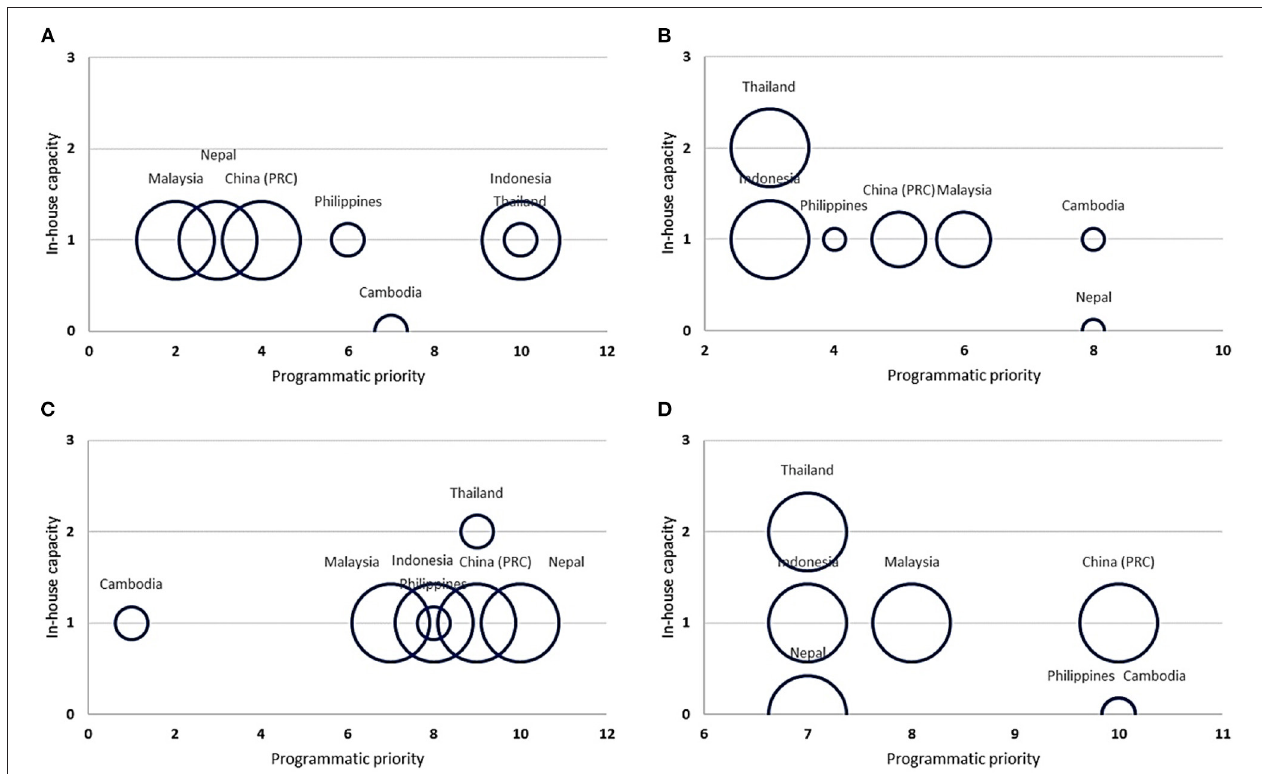
FIGURE 5 | Comparative mapping of domestic scientific capacity, programmatic priority and funding status for 4 crop protection domains in seven Asia–Pacific countries. Plots are drawn for pest/disease biology and ecology (A) , biological control (B) , agronomy and agro-ecology (C) and varietal resistance (D) . For each domain and country, bubble size refers to the current funding status (i.e., low, intermediate, high). In all graphs, except for B, the largest bubble size refers to “intermediate funding”. Programmatic priorities refer to countries’ envisioned “model” IPM framework and are ranked from 0 to 10 ( Figure 1 ), while domestic capacity in a given domain is plotted on a 0–2 scale.